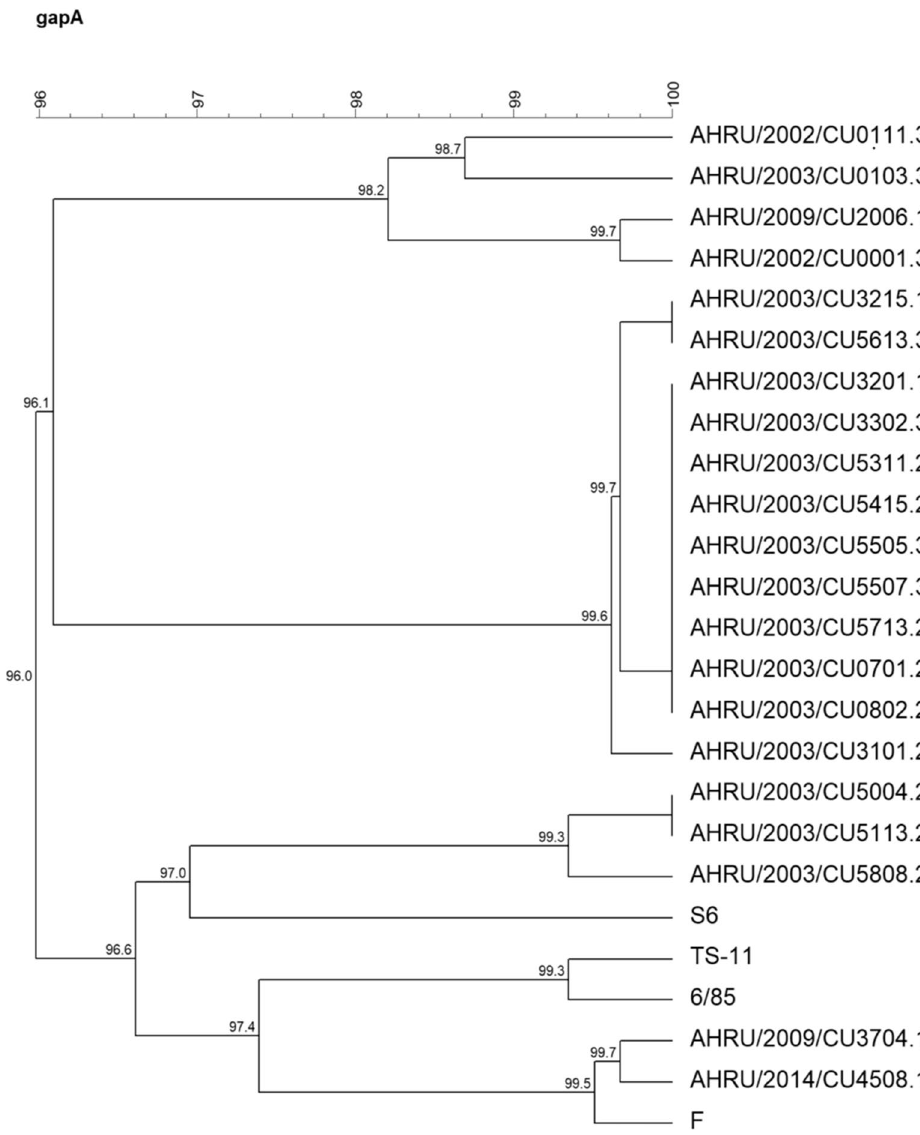
Figure 2. A phylogenetic tree of Thai MG and reference strains based on the alignment of the partial gapA gene was constructed with the unweighted pair group method with arithmetic mean (UPGMA) using Bionumeric version 7.6